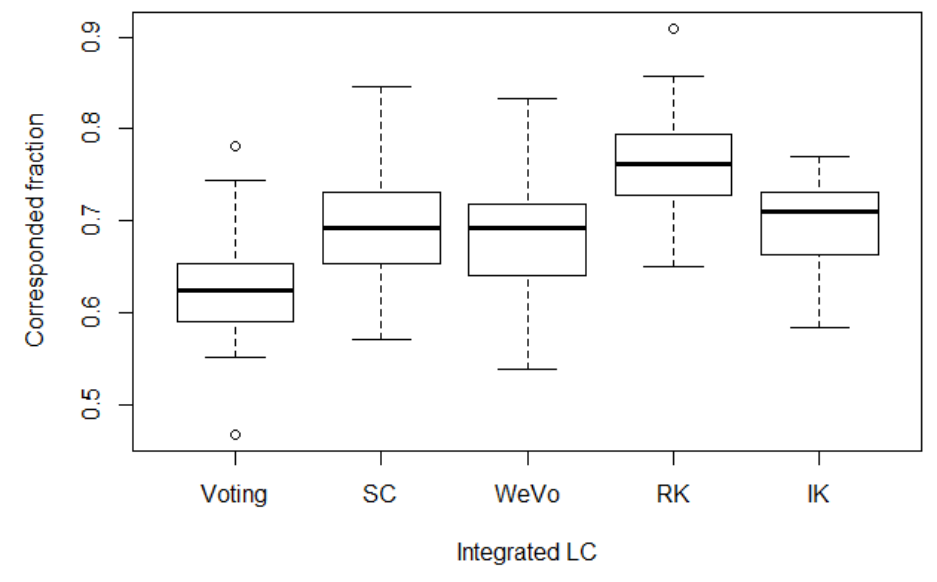
Figure 8. Correspondence of integrated LC with reference sample LC (10-fold cross validation).